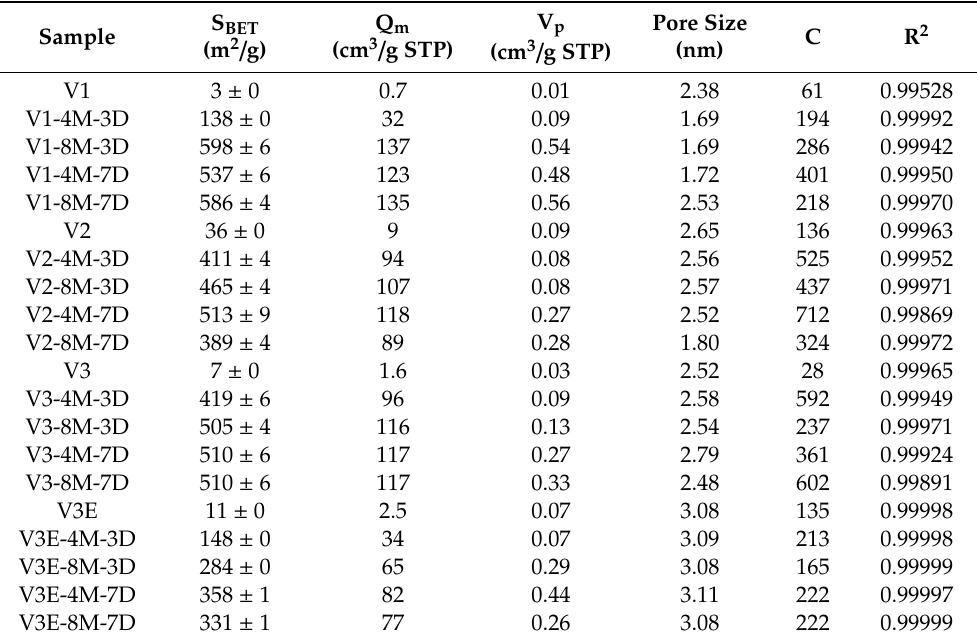
Figure 5 . Nitrogen adsorption–desorption isotherms of V1 ( a ), V2 ( b ), V3 ( c ), and V3E ( d ). Note: The right ordinate scale is for the untreated samples; the left ordinate scale is for the treated samples. Table 4. Specific surface area (S BET ), adsorption capacity (Q m ), pore volume (V p ), BET constant (C), and correlation coe ffi cient (R 2 ) results from adsorption–desorption nitrogen measurements for V1, V2, V3, and their treated